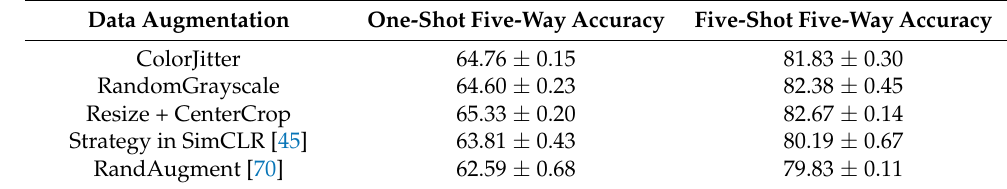
Table 6. Comparison of the accuracy (%) of a five-way task when performed with five shots and one shot with different data augmentation. We report all results with a 95% confidence